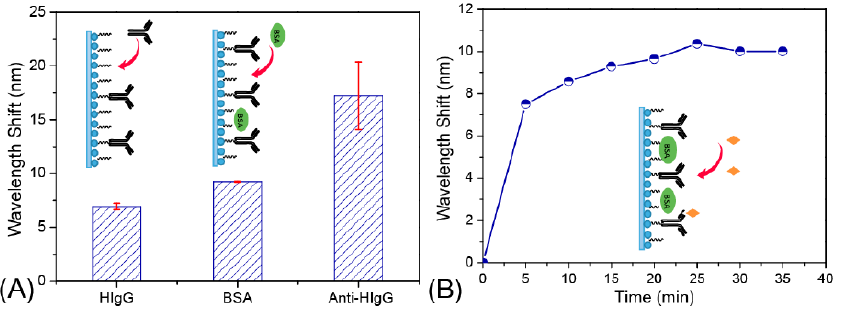
Figure 7. ( A ) A summary scheme of the reflection configuration setup; ( B ) SEM image of the synthesized AgNPs used for LSPR biosensing; ( C ) UV-Vis spectra of AgNPs solutions; ( D ) Histogram with the particle size distribution of AgNPs. Reprinted with permission of [26].